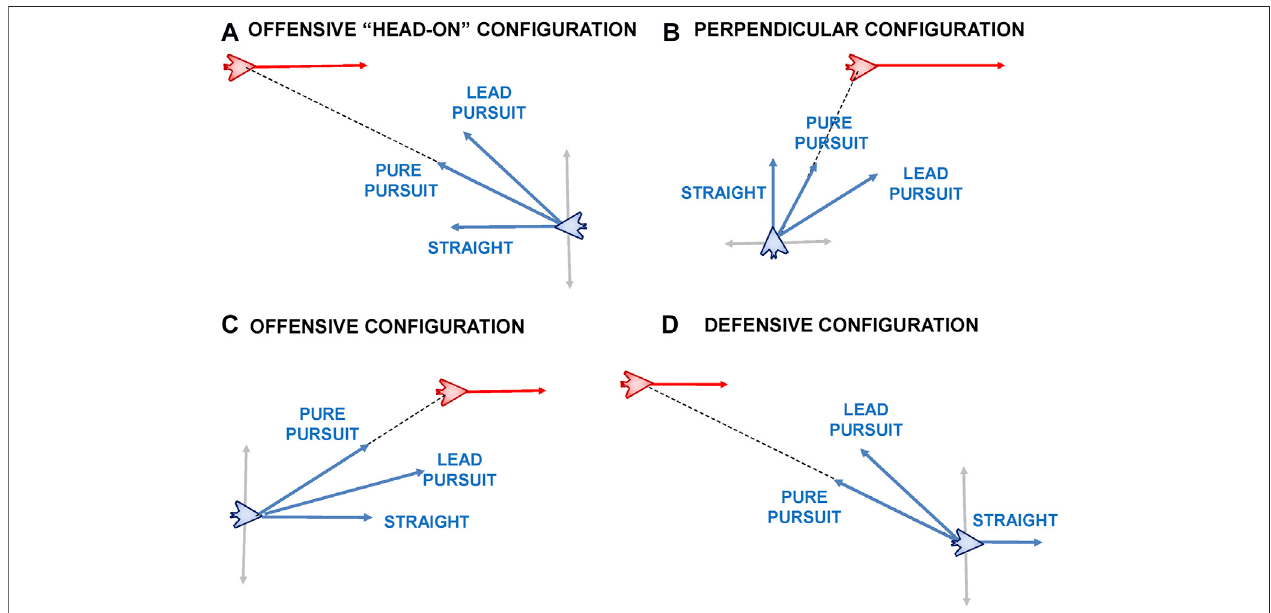
FIGURE 10 | Behaviour similarities under different initial conditions which could lead to potential confusion in successful behaviour